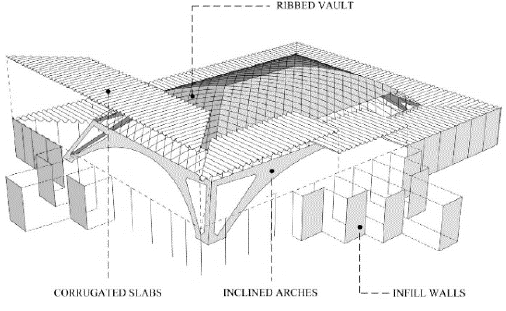
Figure 4. The structural elements indication in hall C.